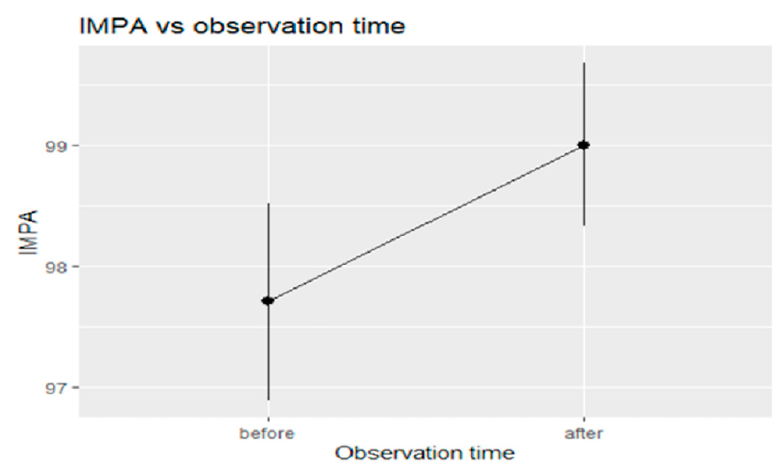
Figure 9. Trend in MP-SN over time from T0 to T1.